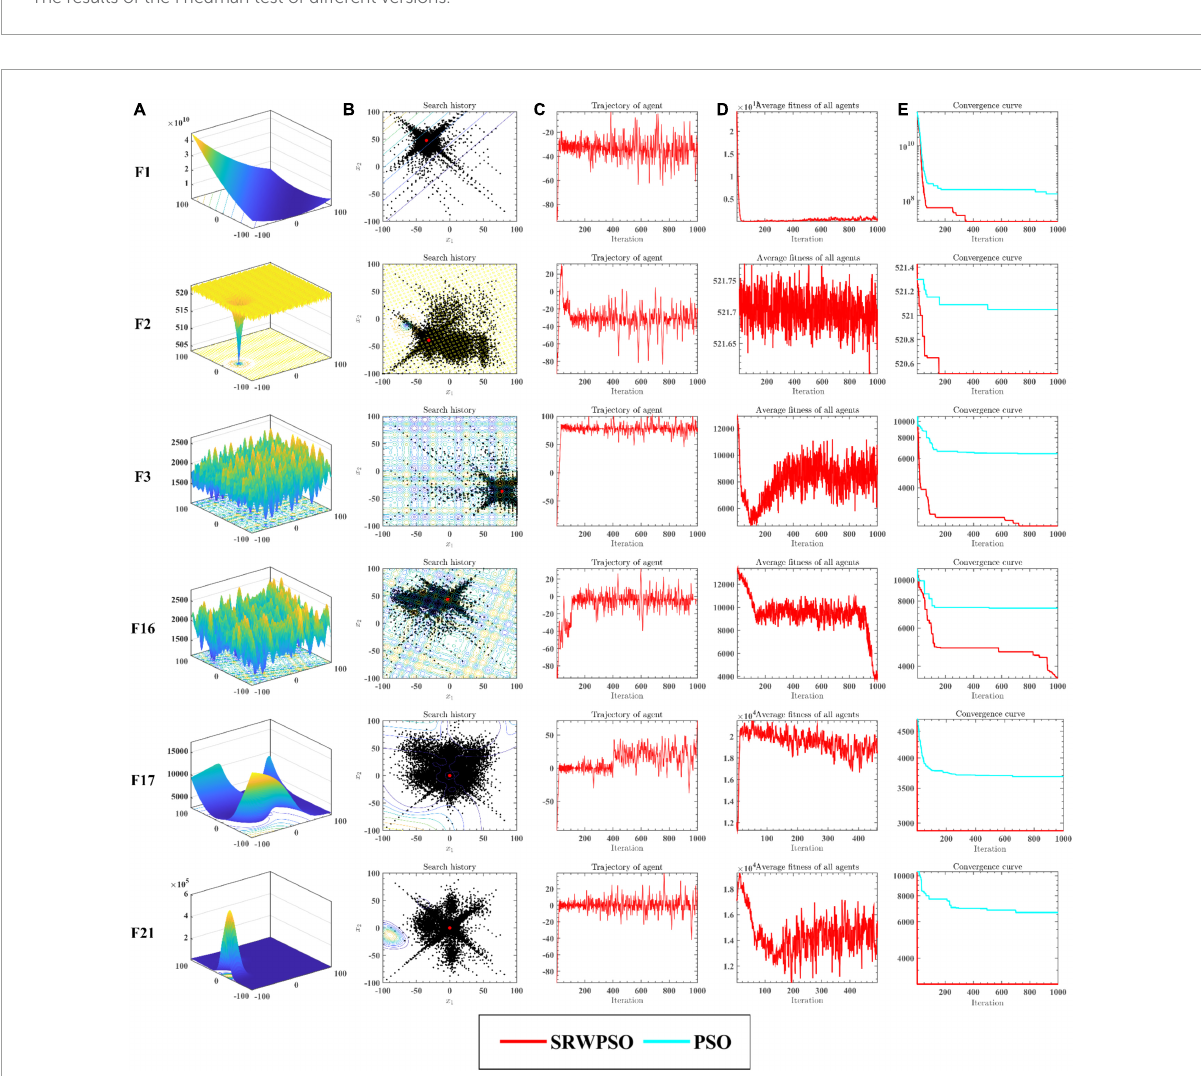
FIGURE5 The analysis results of SRWPSO and PSO from multiple perspectives. See section 6.3 for